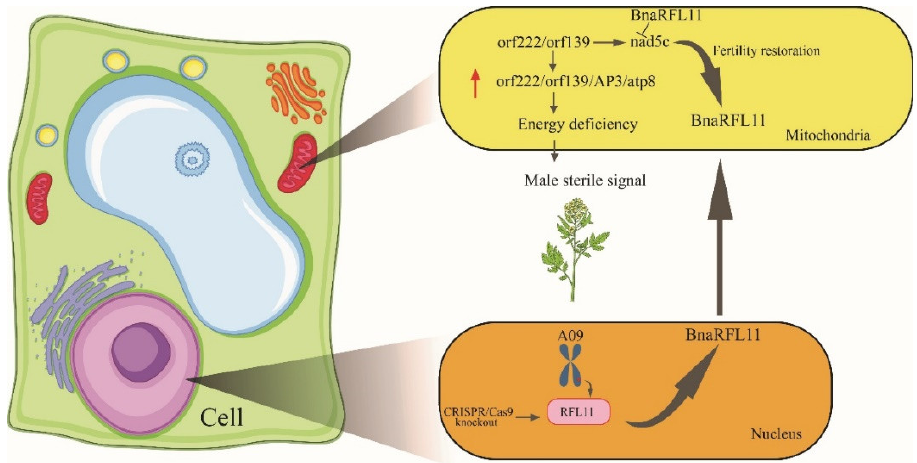
Figure 11. Putative model for male sterility in the current study on rapeseed. Red arrow indicating upregulation.